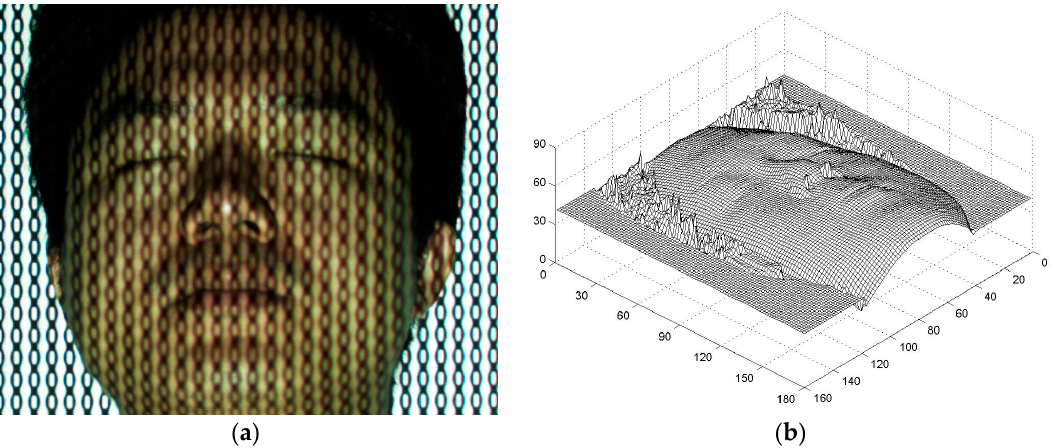
Figure 11. ( a ) Distortion composite pattern modulated by a volunteer’s face depth; ( b ) rebuilt 3D digital profile of a real human face (Scale: mm).